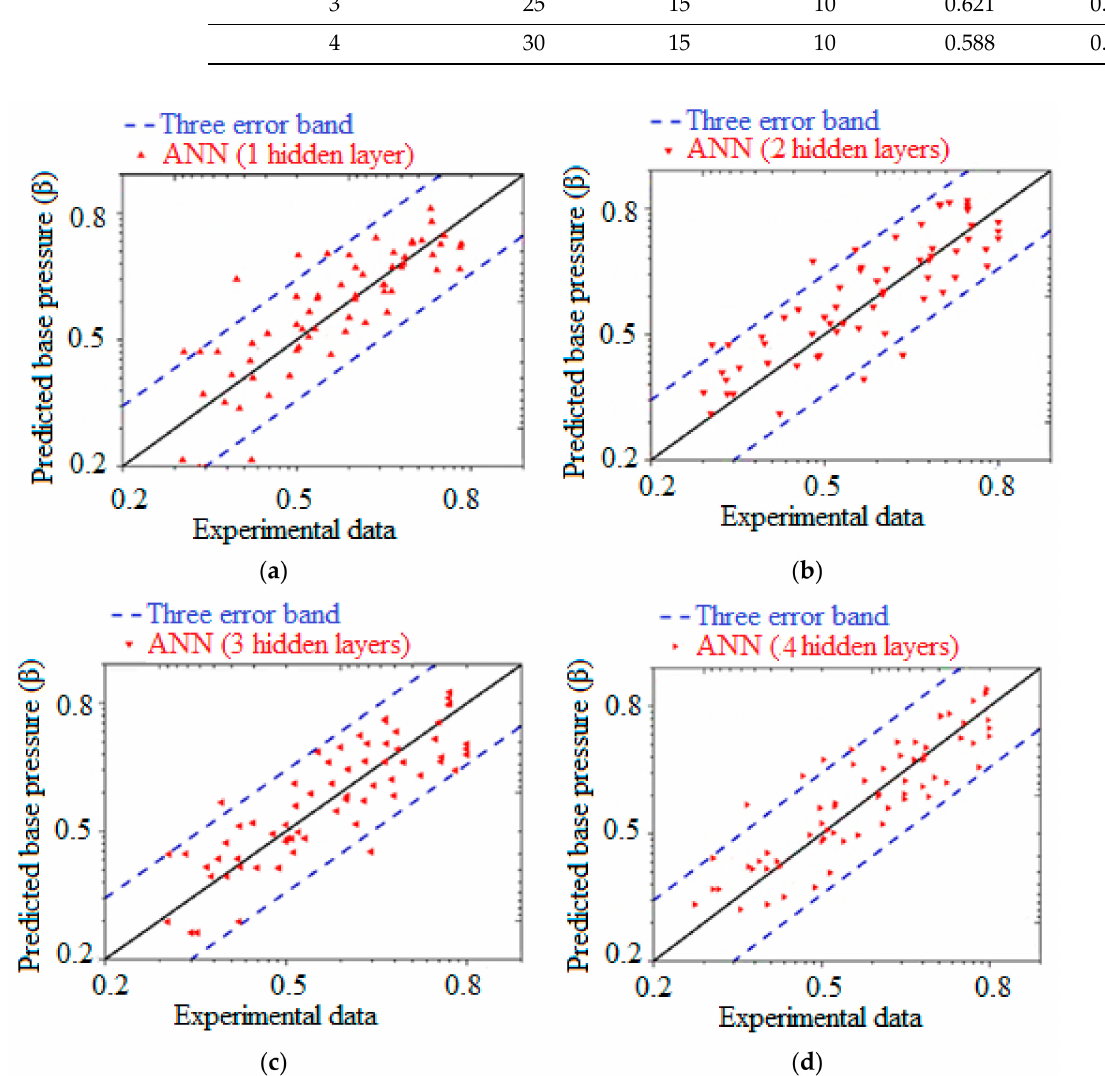
Figure 9. Variation of ANN predicted base pressure ( β ) against experiments: ( a ) One hidden layer, ( b ) two hidden layers, ( c ) three hidden layers, ( d ) four hidden